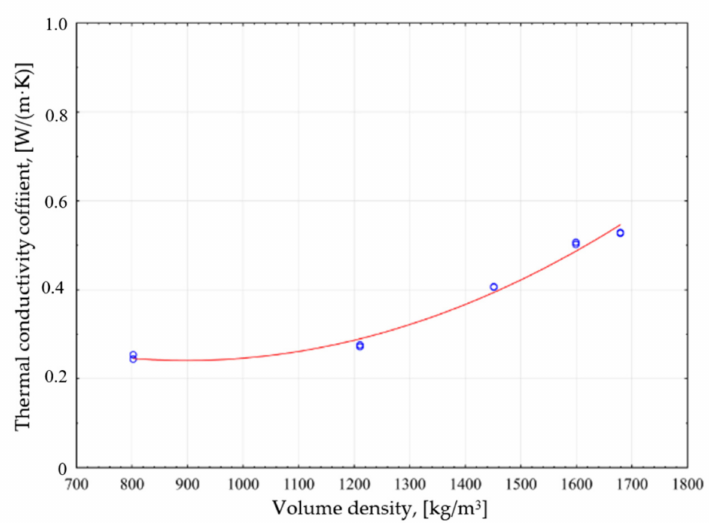
Figure 6. Dependence of thermal conductivity on the volume density of modified GFG samples with a fraction of 0.25–0.5